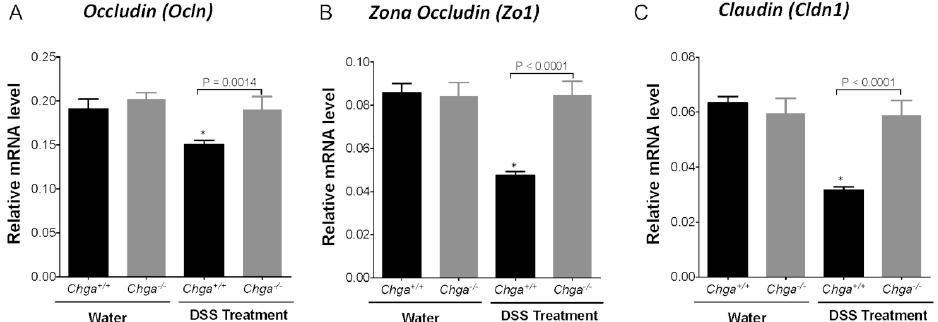
Figure 3. Deletion of chromogranin-A gene ( Chga ) maintains colonic tight junction (TJ) mRNA expression proteins in acute dextran sulphate sodium (DSS)-induced colitis. Wild-type ( Chga +/+ ) and Chga -knockout ( Chga − / − ) mice were given 5% DSS solution for five days in the drinking water to induce colitis. Control mice received water without DSS. Mice were sacrificed at day five, and colonic tissues were processed for mRNA expression. ( A – C ) Whole colonic mRNA expression of tight junction (TJ) proteins (occludin [ Ocln ], zonula occludens-1 [ Zo1 ], claudin [ Cldn1 ]) quantified RT-qPCR. One-way ANOVA followed by Tukey’s multiple comparison test. Each value represents the mean ± SEM, n = 6–8 per group. * p < 0.005 refers to significance compared with water treatment groups.